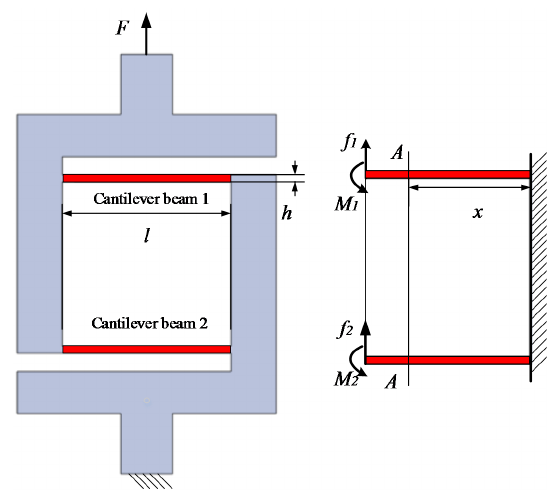
Figure 3. Force analysis of the double cantilever beam (DCB) elastic leg.